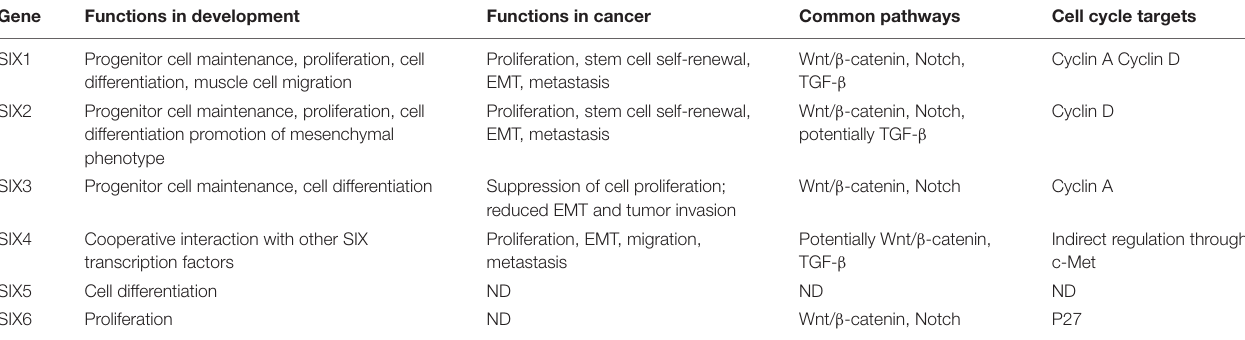
TABLE 3 | Common functions and pathways of SIX family genes in development and cancer